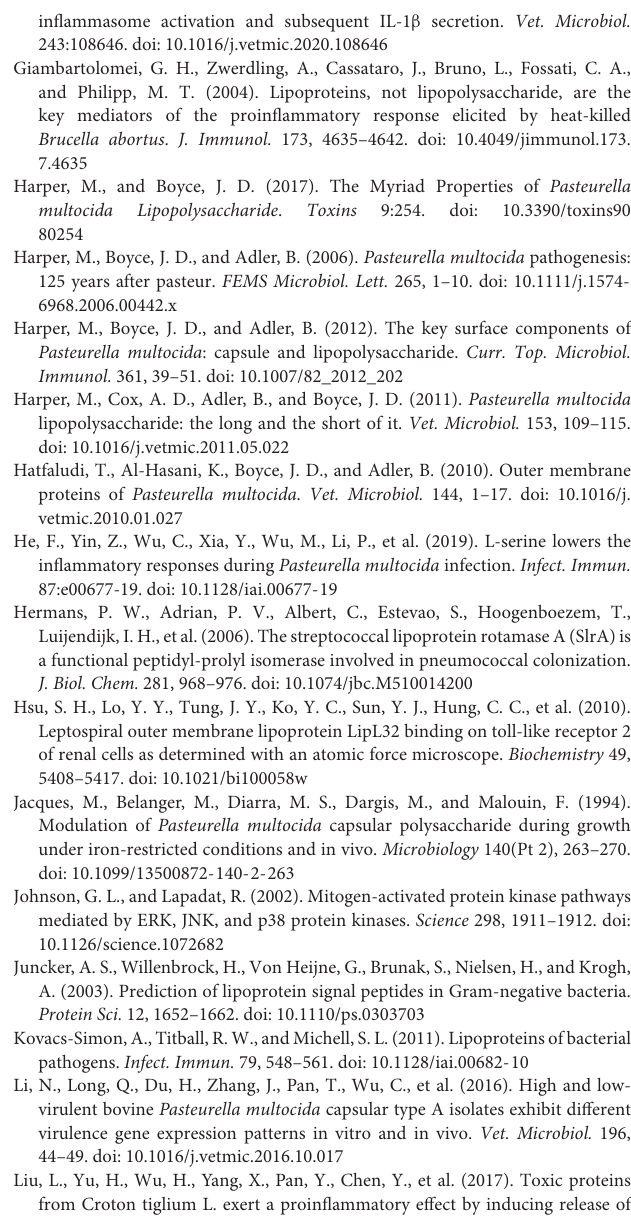
were pooled from three independent experiments with 6 replicates per group. Statistical significance was analyzed with one-way ANOVA and expressed as TABLE S1 | Predicted 67 Lipoproteins of PmCQ2 based on whole genome sequencing. TABLE S2 | Significant up-regulated 37 lipoproteins of PmCQ2 based on transcriptome sequencing. TABLE S3 | Predicted 53 iron utilization related genes of PmCQ2 based on whole genome sequencing. TABLE S4 | qRT-PCR Primers used in this